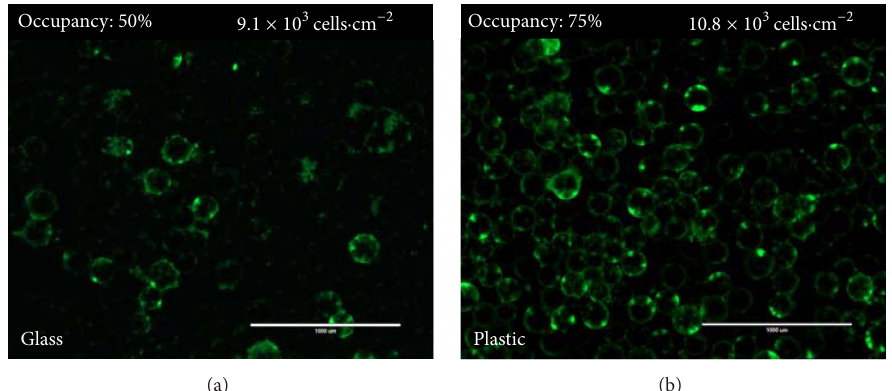
Figure 4: SYBRGreen stained hUC MSCs on HCl-treated Glass-coated microcarriers (a) and Plastic Plus microcarriers (b) after 3 days of culture in 1mL DMEM medium in an ultralow attachment well plate at a seeding density of 8000 cells ⋅ cm −2 (scale bar = 1000 𝜇 m).